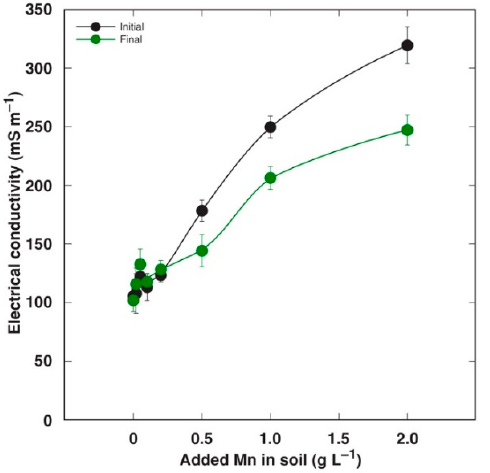
Figure 5. Effect of treatment with different concentration of Mn on initial (week 1) and final (week 9) substrate electrical conductivity in containers with H. maximum (Experiment 2). Data are means ± SE from 5 replicates, each with 4 measurements, for each point.